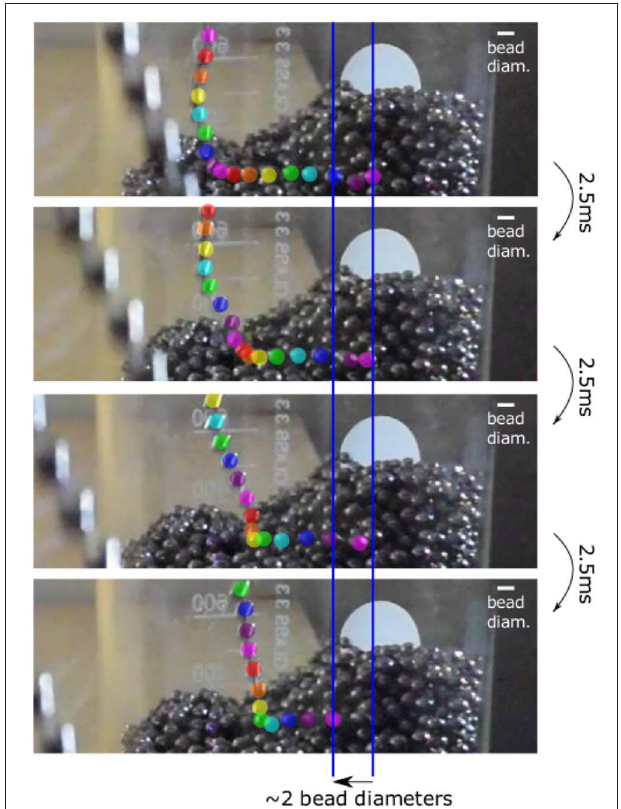
FIGURE 4 | A time sequence of 7.5 ms using a 50 m chain of 4.5 mm beads. Individual chain beads are traced by different colors. Adapted from Flekkøy et al. [ 10] with permission from the